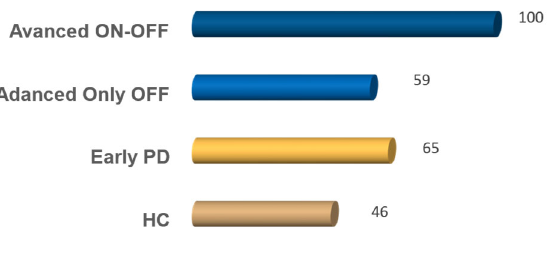
Figure 2. Percentage of samples for each subgroup that have been recorded with a professional microphone.